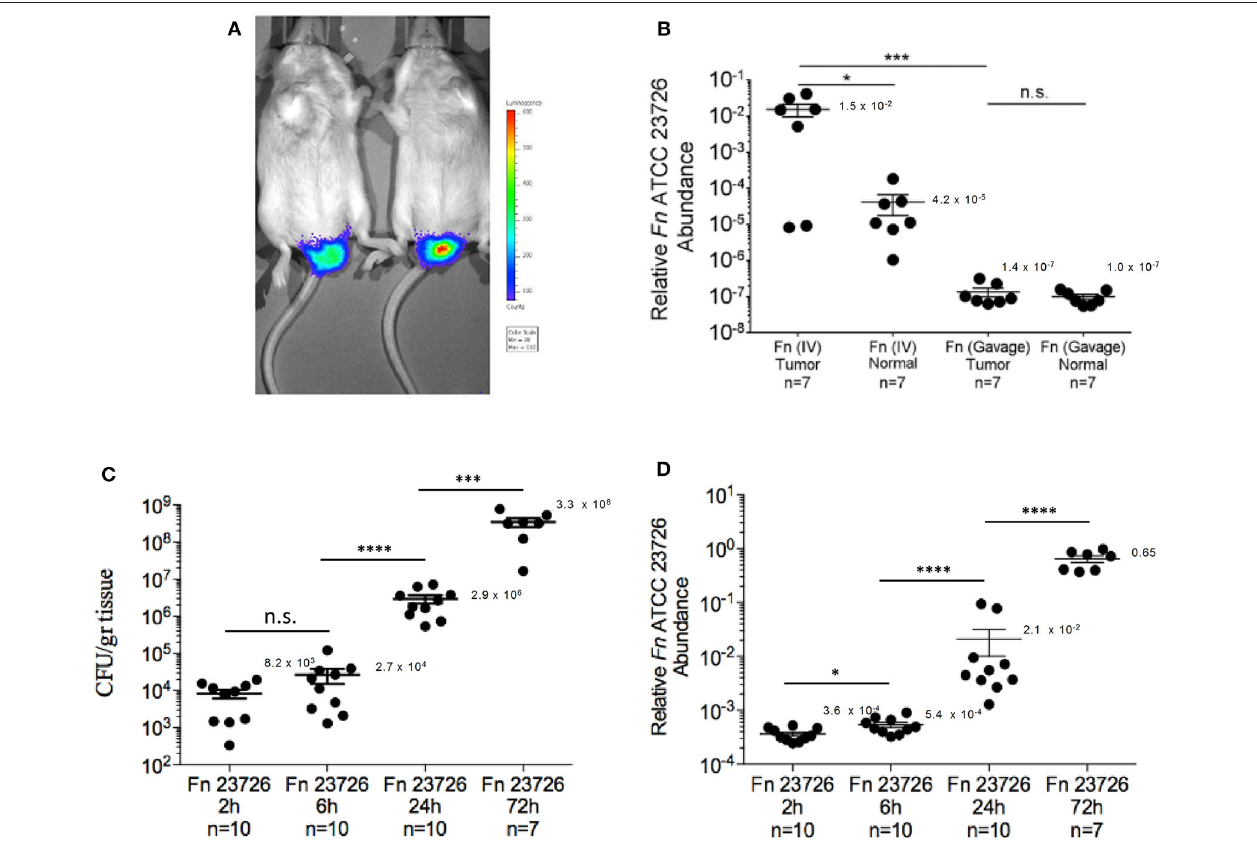
FIGURE 3 | Kinetics of F. nucleatum ATCC 23726 enrichment in the CT-26 orthotopic model. (A) Detection of implanted CT-26 cells stably transfected with the luciferase (luc) gene under the mucosa of the distal rectum of C57BL/6 wild-type mice. (B) Relative fusobacterial gDNA abundance (2 − 1 Ct ) in tumor samples and in adjacent normal colon samples from CT26 transplanted BALB/cJ mice inoculated once with 5 × 10 7 -1 × 10 8 intravenously (IV) or three times by oral gavage (Gavage) with 10 ∼ 10 F. nucleatum ATCC 23726. * p < 0.05, Bonferroni-corrected two-tallied Wilcoxon test, *** p < 0.001, Bonferroni-corrected two-tailed Mann-Whitney test. (C) Abundance (CFU/gr tissue) and (D) relative fusobacterial gDNA abundance (2 − 1 Ct ) in tumor samples collected 2, 6, 24, and 72h after IV inoculation of CT26 transplanted BALB/cJ mice with 5 × 10 7 -1 × 10 8 F. nucleatum ATCC 23726. * p = 0.02, *** p = 0.0001, **** p < 0.0001, Bonferroni-corrected two-tailed Mann-Whitney test. Error bars show Mean ±